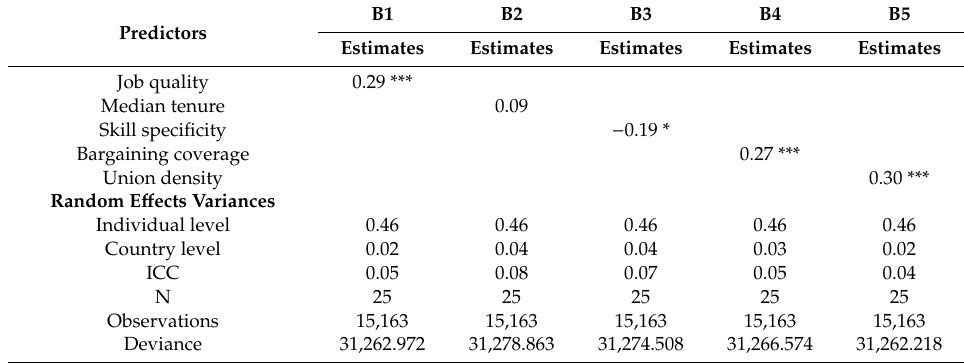
Table 2. E ff ects of intrinsic job quality and its determinants, as highlighted by varieties of capitalism (VoC) and power resources theory (PRT), on job preference orientations—a multi-level regression.